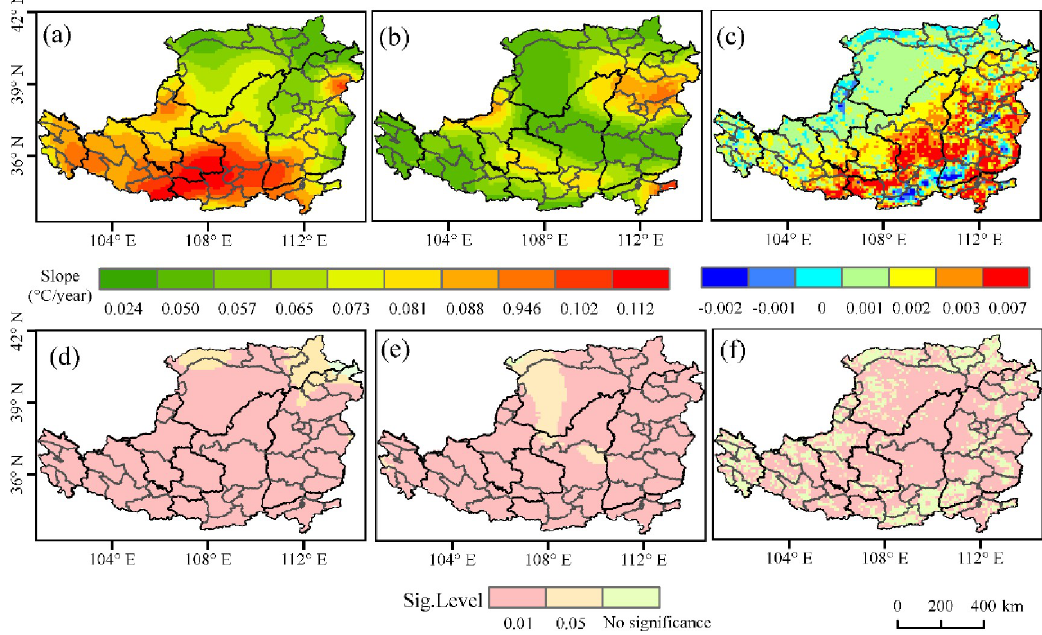
Fig 2. Trends of T max / T min and NDVI in spring over the Loess Plateau from 1982 to 2015. (a) the slope of T max; (b) the slope of T min ; (c) the slope of NDVI; (d) the significance level of T max trends; (e) the significance level of T min trends; and (f) the significance level of NDVI